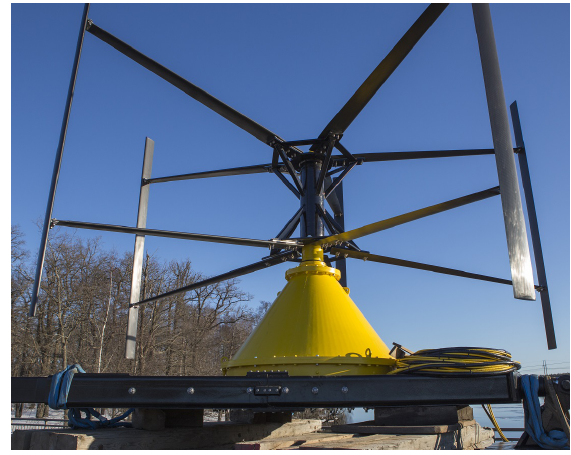
Prototype marine current energy converter before deployment in the river Dalälven,